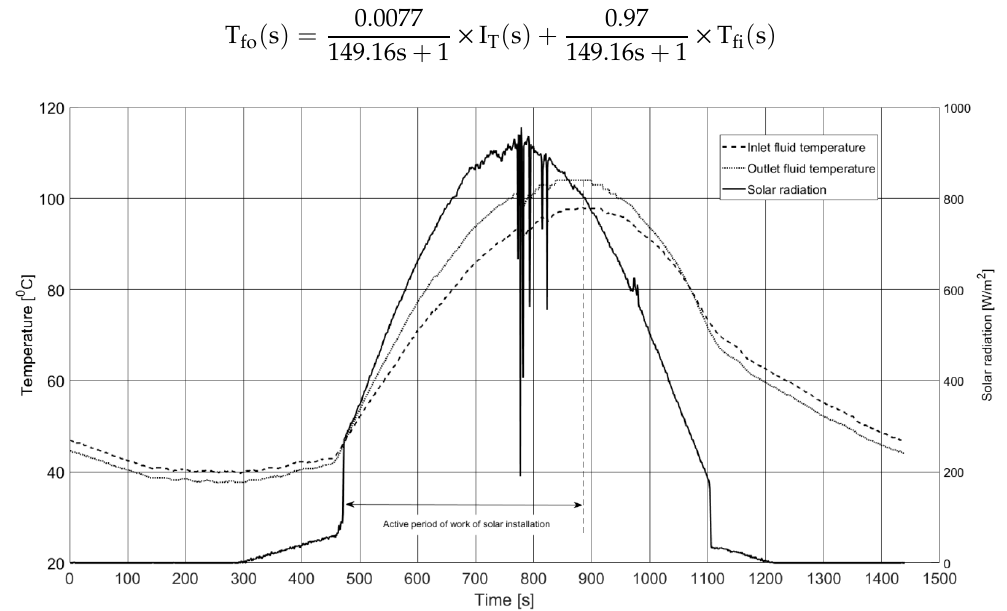
Figure 15. Solar irradiance and working medium temperature values in the system during the experiment (test stand II).